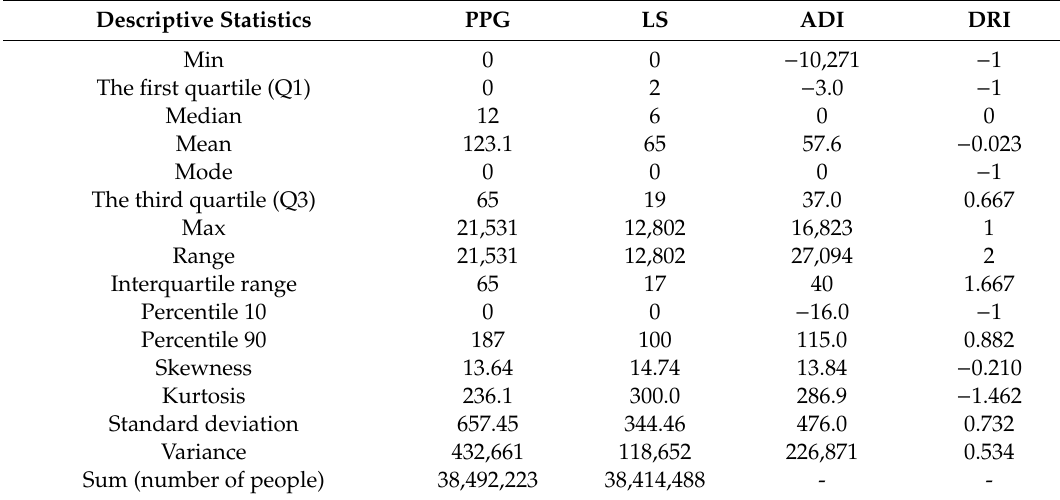
Table 3. Descriptive statistics of PPG, LS and disparity indexes.